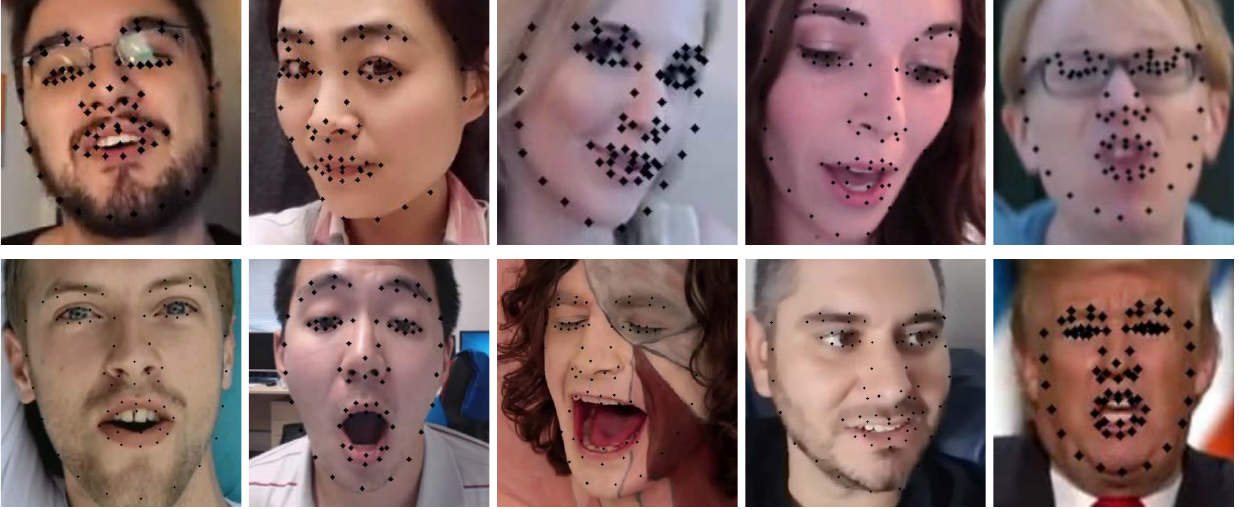
Fig. 7 Landmark tracking